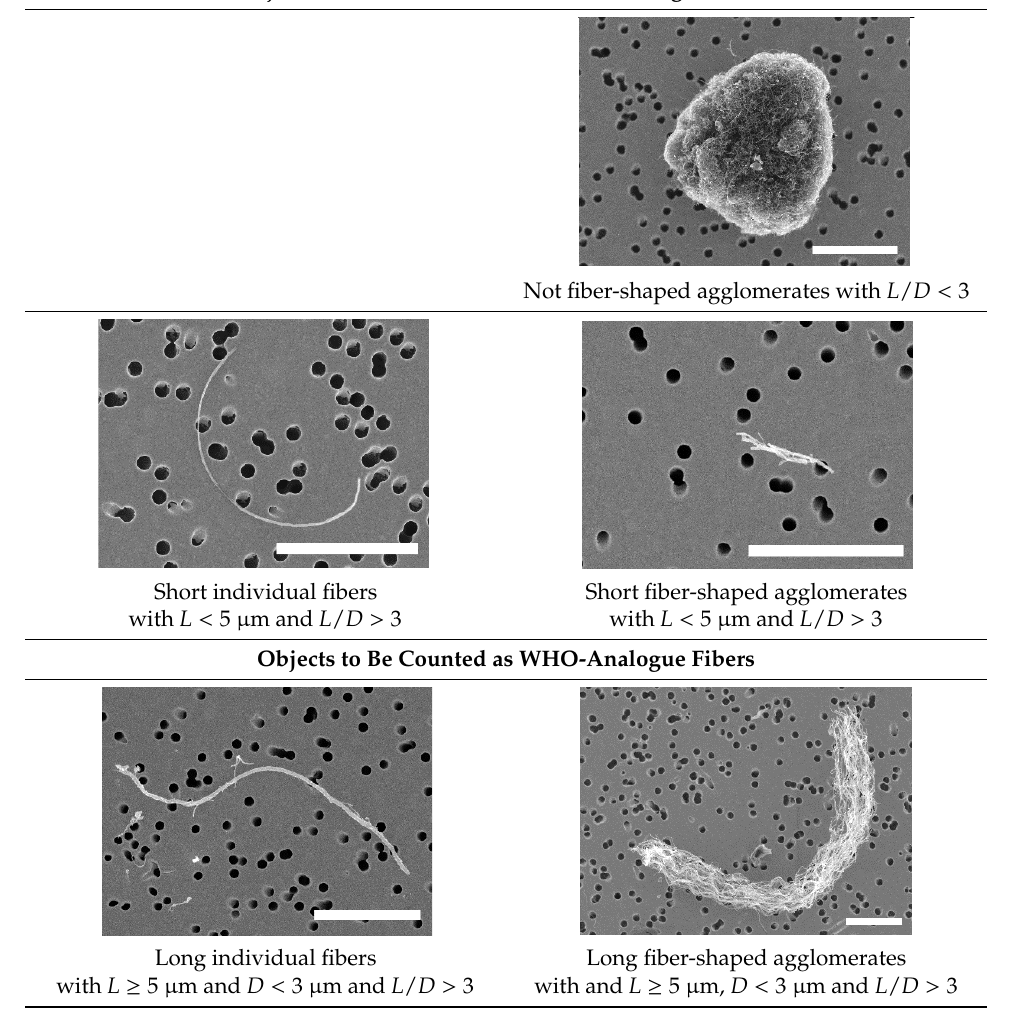
Table 6. Examples of counting rules for fiber numbers in EM images.